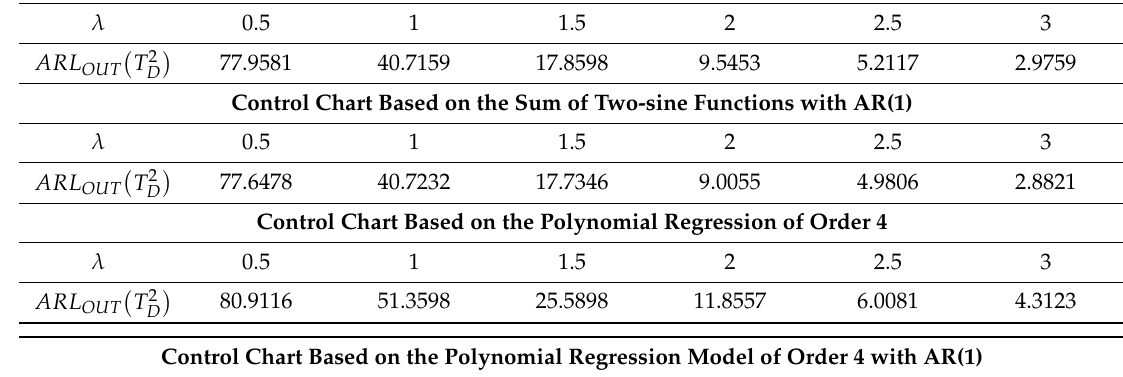
Control Chart Based on the Polynomial Regression Model of Order 4 with